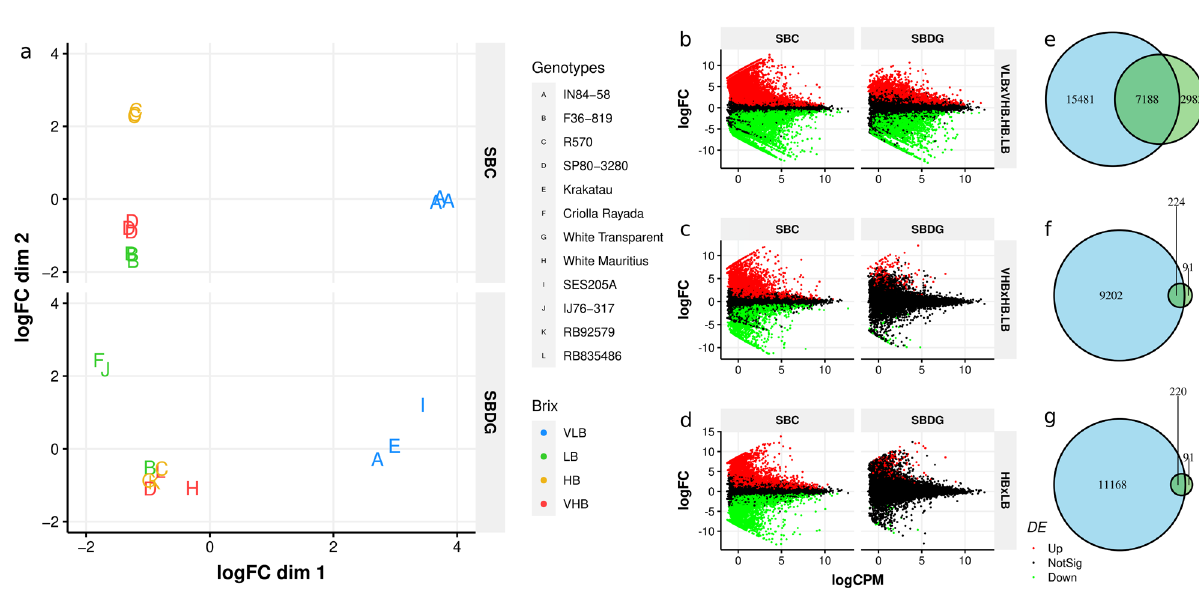
Figure 1 – Gene expression patterns and differentially expressed genes for both sampling strategies. ( a ) Multidimensional scaling (MDS) plot showing pairwise distances between samples based on the most divergent genes for each pair. The panels represent the MDS plot for the strategy based on clones (SBC) and the strategy based on diverse genotypes (SBDG), respectively. ( b , c , d ) Mean-difference plot grid showing differentially expressed genes for all contrasts and strategies. Fold changes (logFC) and average expression levels in counts per million (logCPM) are shown in base 2 log scales. The rows indicate the three orthogonal contrasts, while the columns correspond to the strategies of sampling biological replicates. Colors represent the result of differential expression tests (p < 0.05, after FDR correction for multiple tests). ( e , f , g ) Differentially expressed genes shared by the strategies based on clones and on diverse genotypes. The diagrams represent the number of genes detected as significantly differentially expressed in the contrasts. The strategy based on clones is in blue, while the strategy based on diverse genotypes is in green. The figures represent orthogonal contrasts VLB × HB.LB. VHB ( b , e ), VHB × HB.LB ( c , f ), and HB × LB ( d , g